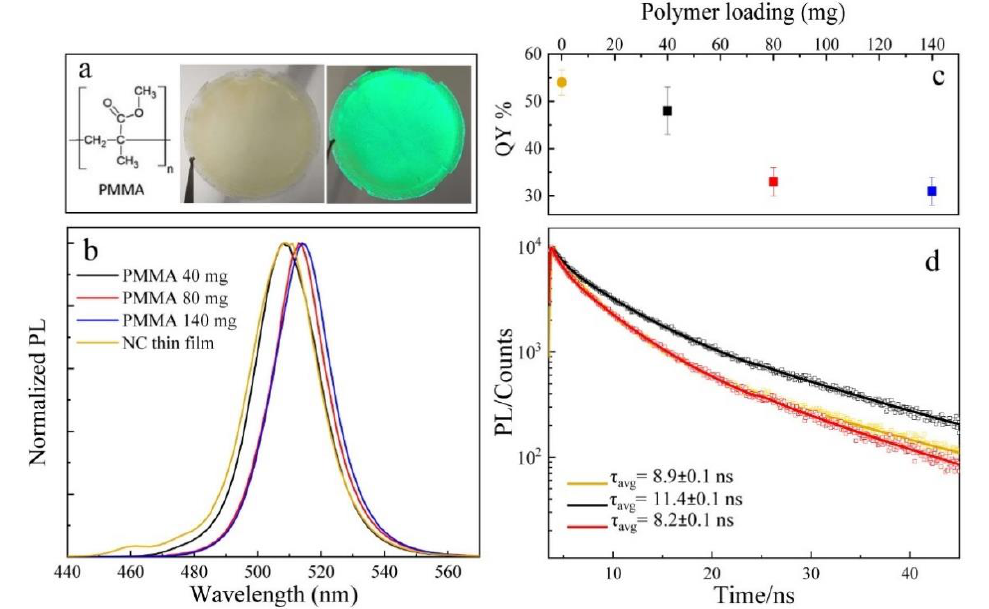
Figure 2. ( a ) Pictures of the free-standing nanocomposite film (80 mg PMMA) under white (left) and UV light (right) along with the molecular structure of the PMMA. ( b ) Steady state photoluminescence (PL) spectra (λ ex = 375 nm) and ( c ) photoluminescence quantum yield (PL QY) of free-standing films of PNCs at different PMMA (40 mg, black line and symbol, 80 mg, red line and symbol, 140 mg, blue line and symbol) and fixed NCs loading (0.04 mmol) compared to that of CsPbBr 3 NC thin